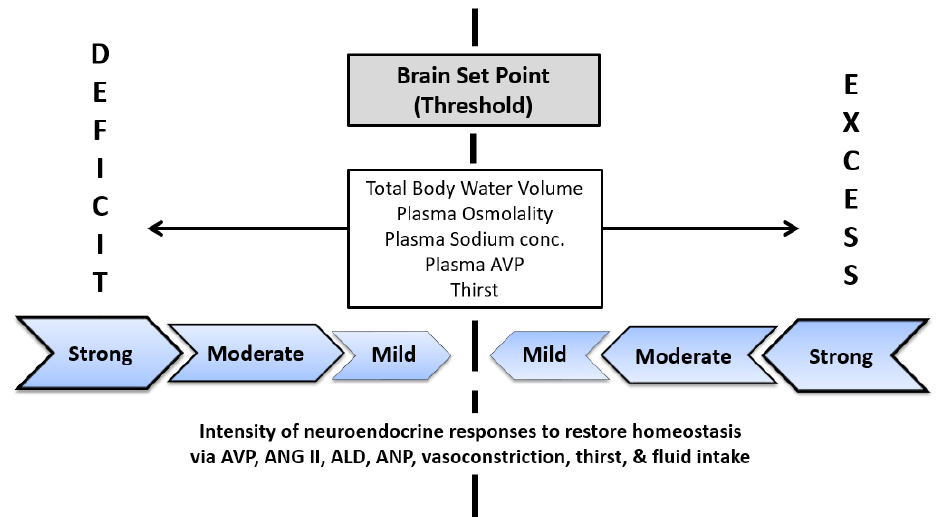
Figure 3. A proposed schematic of a method to assess human daily water requirements by measuring the intensity of neuroendocrine responses that are employed by the brain to defend homeostasis of body water volume and concentration. These responses and thresholds are inherent hydration biomarkers, and the means by which the brain maintains good health and optimal function. Abbreviations: AVP, arginine vasopressin; ANG II, angiotensin II; ALD, aldosterone; ANP, atrial naturietic peptide.